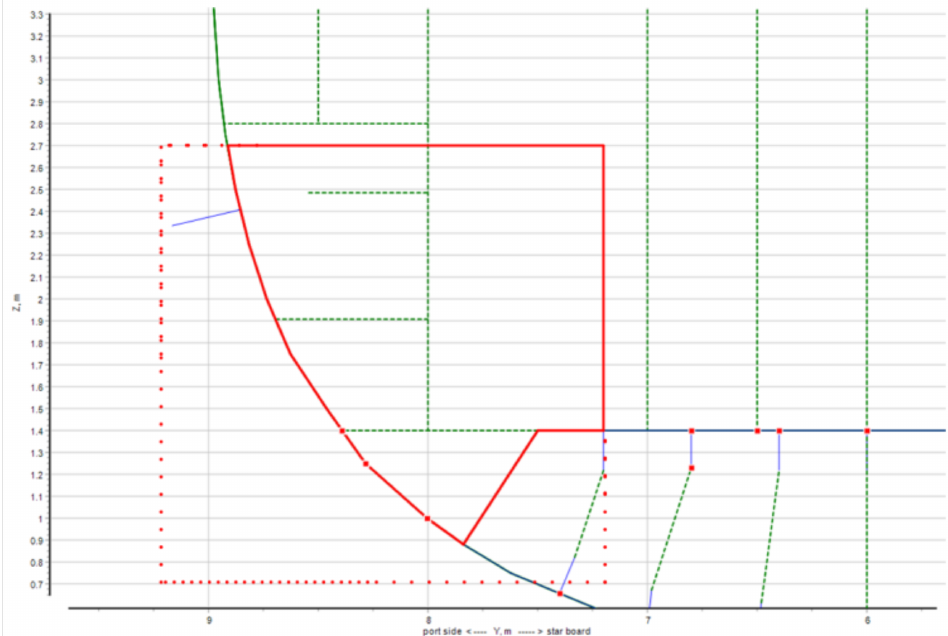
Figure 21. An example of forming the contour of a transverse bulkhead plate in the area of adjacency of the double-bottom plate; while the first polygon is the contour of the transverse bulkhead, the second is the quadrangle of the plate borders. In this Figure: green lines—stiffeners, primary supporting members and adjoining structures, blue lines—beams shown in section, red dotted line—user-specified plate boundaries, red thick line—the result of generating the plate